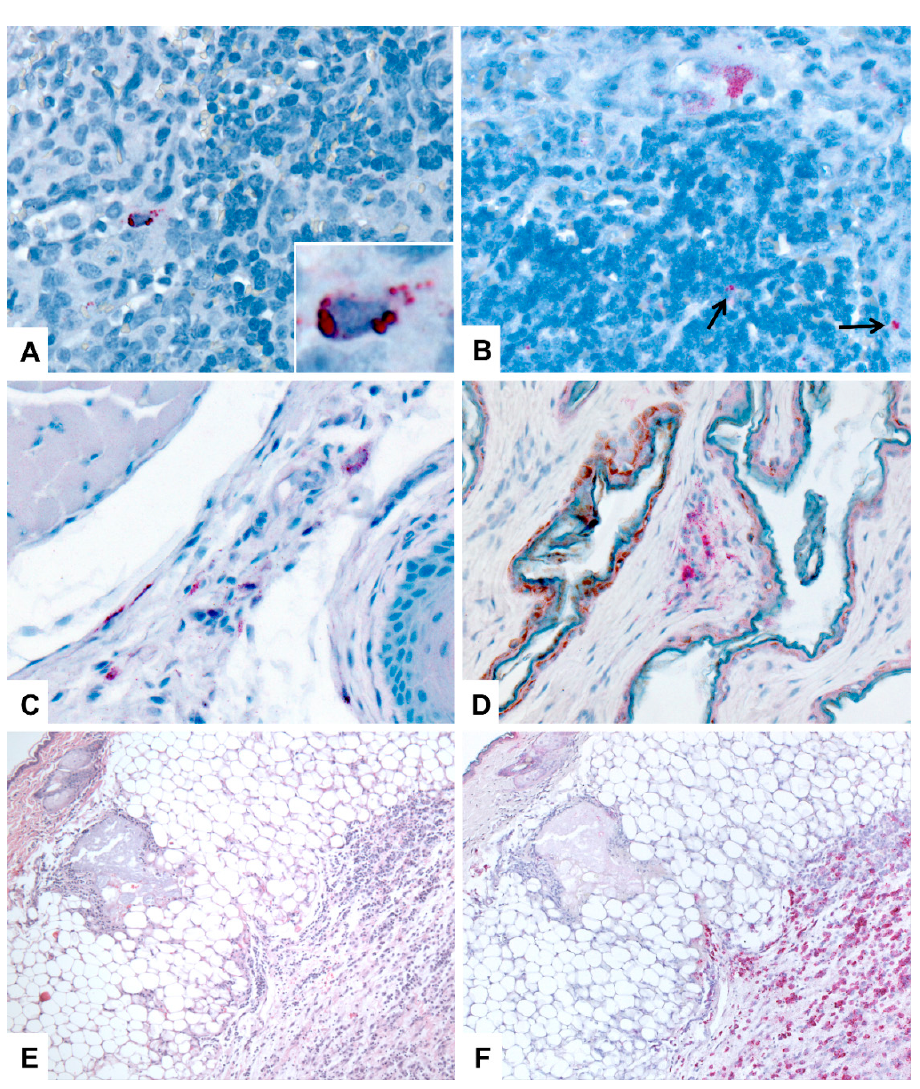
Figure 5. Immunohistochemical (IHC) localization of Marburg viral (MARV) antigen in tissues of Egyptian rousette bats. All IHC stains are immunoalkaline phosphatase with naphthol fast red and hematoxylin counterstain. DPI = days post-inoculation. ( A ) Spleen, 5 DPI. MARV antigen (red) is